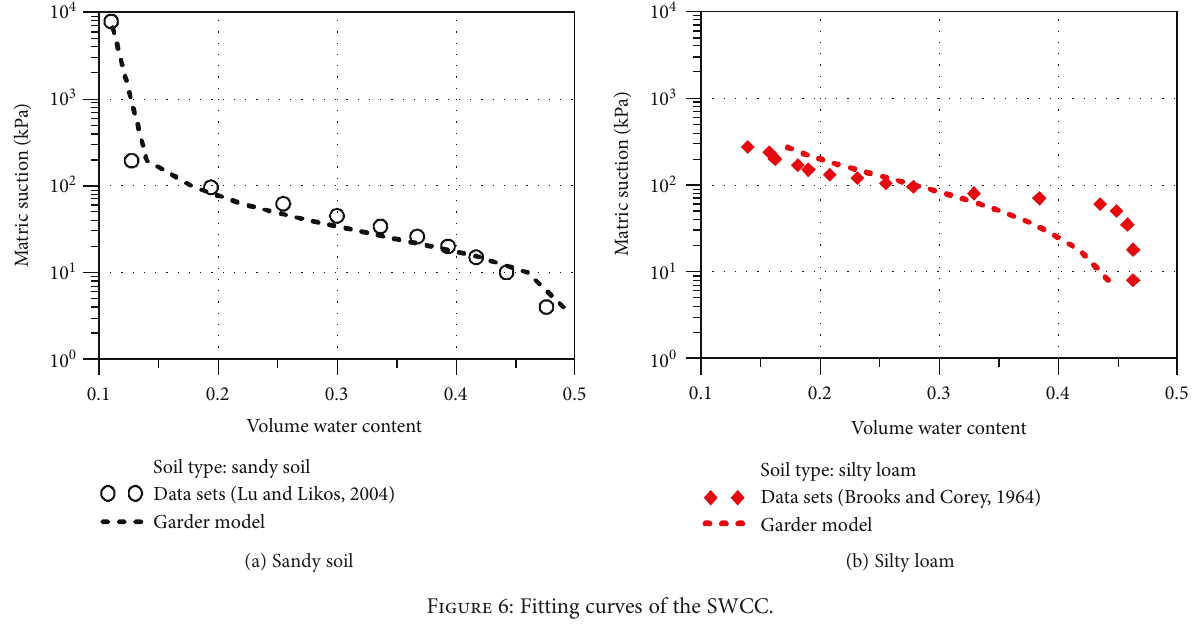
Figure 6: Fitting curves of the SWCC.